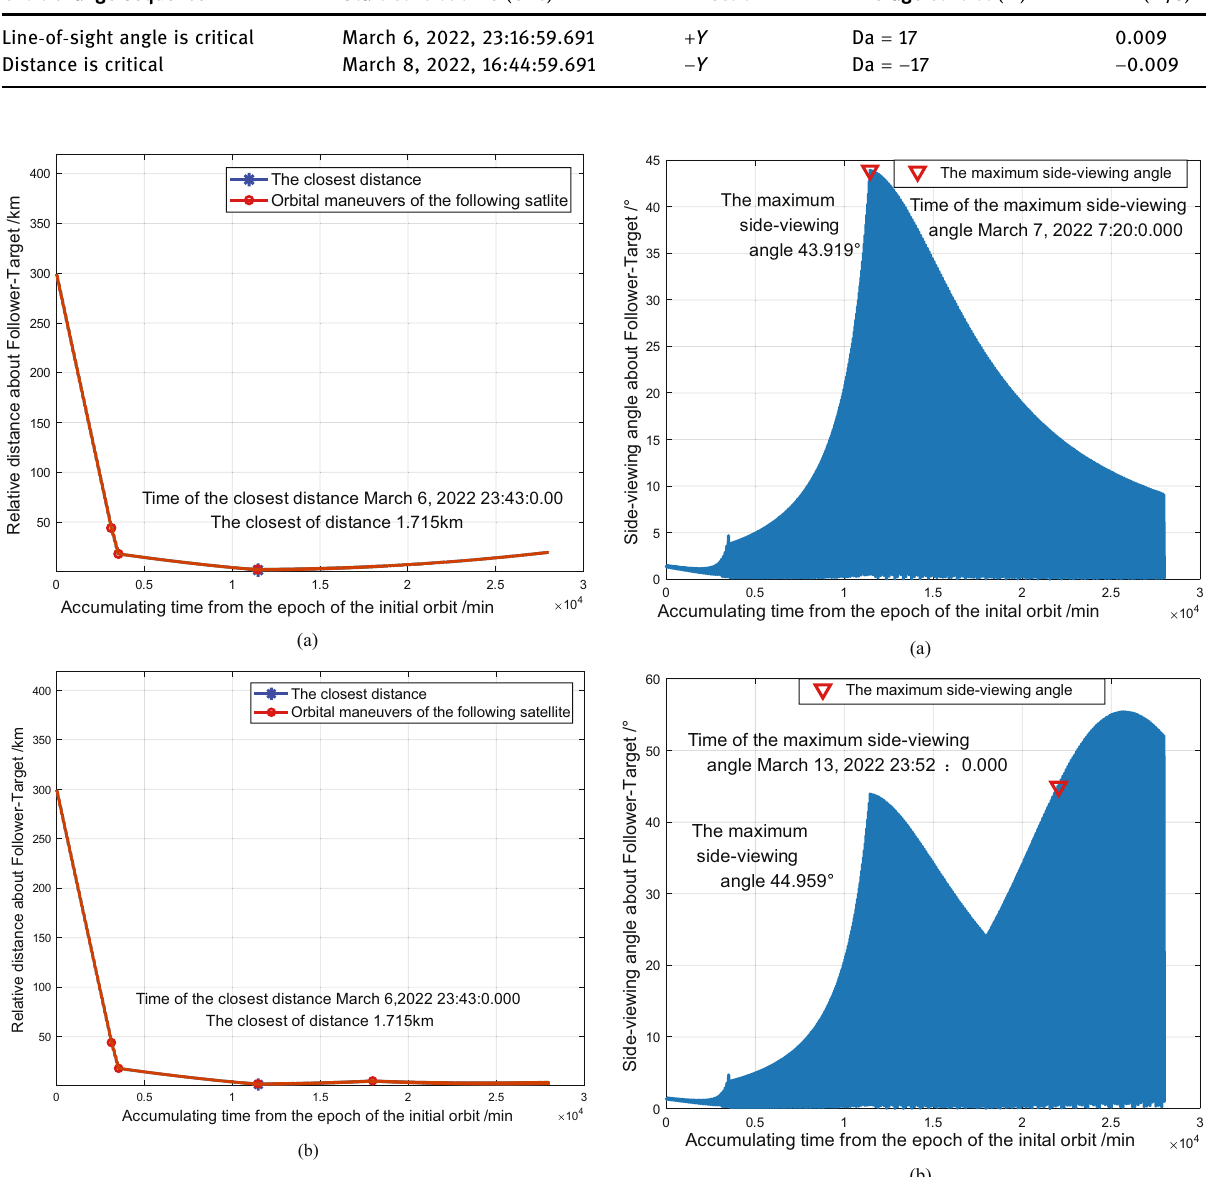
Figure 4: Variation in the relative distance between two satellites caused by ( a ) ascending orbit and ( b ) descending orbit during the hold control system implementation.